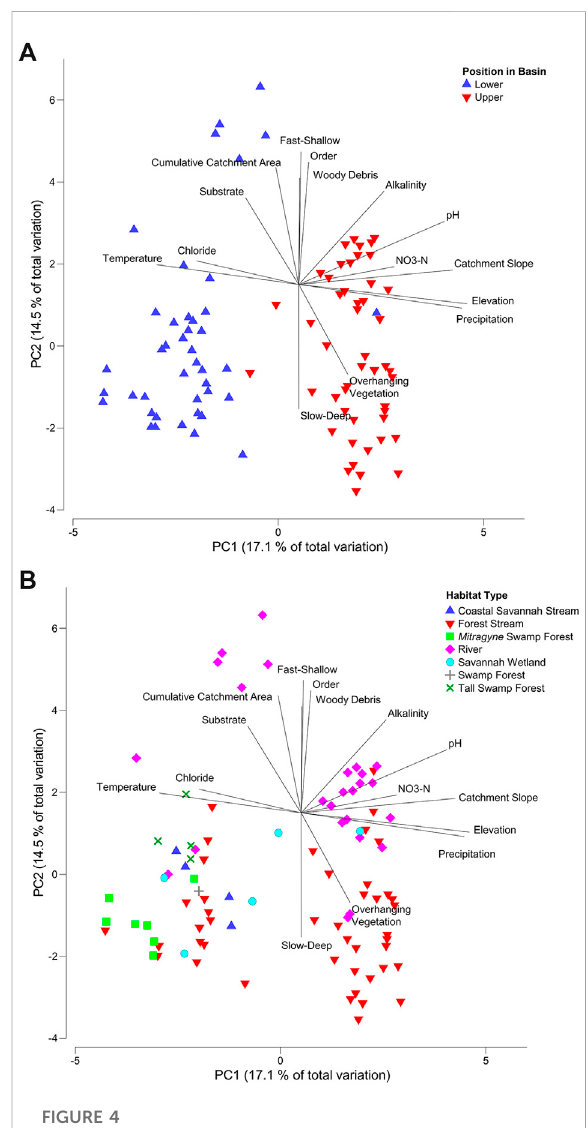
FIGURE 4 PCA with local and landscape scale normalized data using Euclideandistance (A) withpositioninbasin,and (B) habitattypeas factor. Vectors were included only from variables with Pearson ’ s correlation of > 0.5. Temp = temperature. M Alk = total alkalinity. Ave =